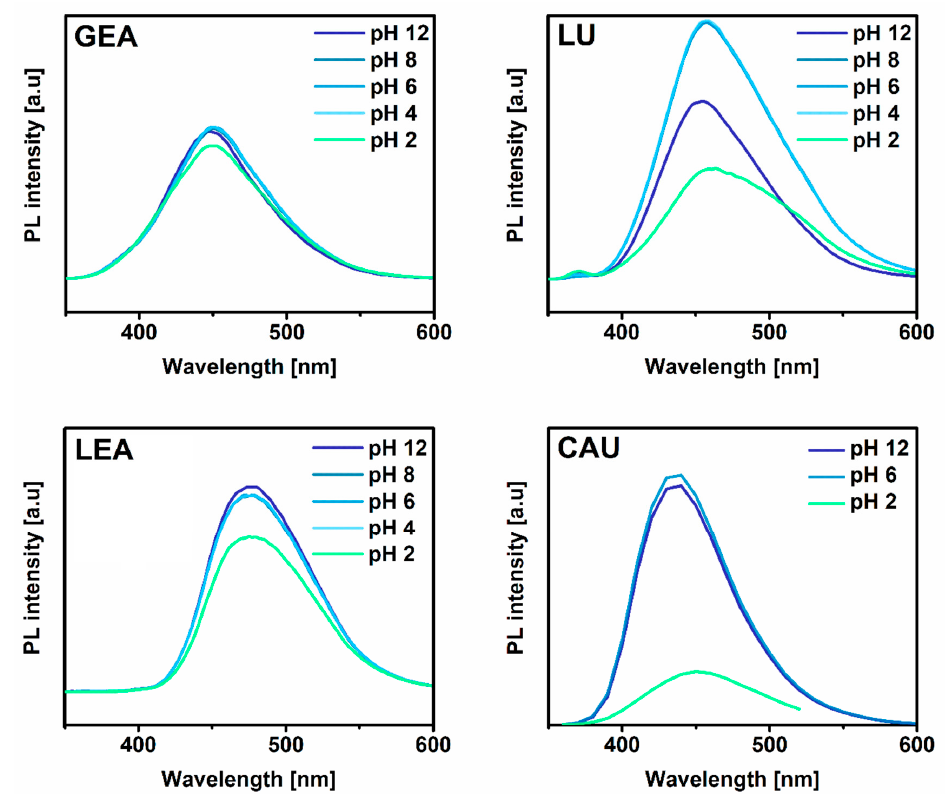
Figure 3. Impact of varying pH in the range from 2 to 12 on photoluminescence properties ( λ exc = 350 nm) of the different types of CDs. PL: photoluminescence.